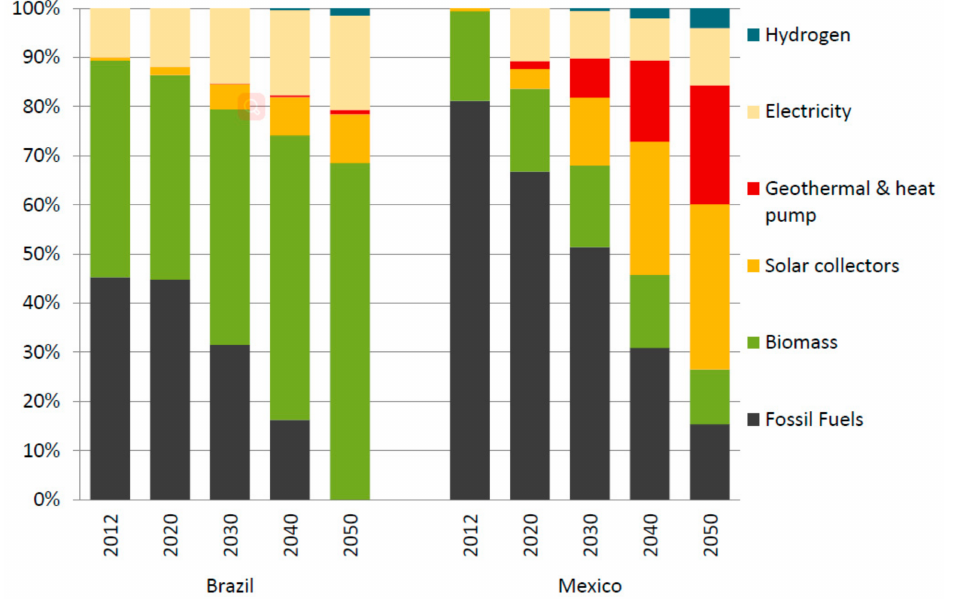
Figure 4. Fuel shares for heat supply (space heat, hot water, process heat) in Brazil and Mexico in